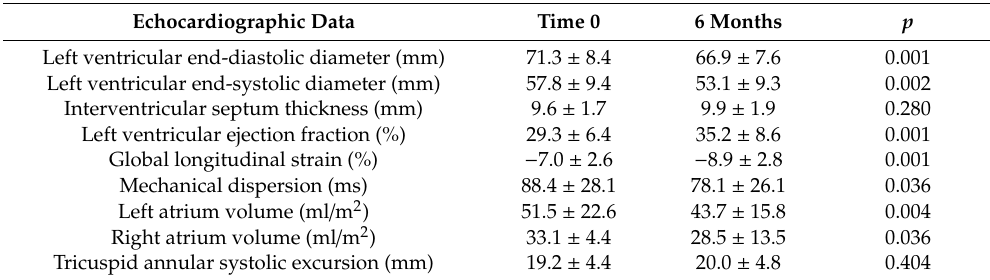
Table 3. Echocardiographic data before and after six months of LCZ696 therapy. Echocardiographic